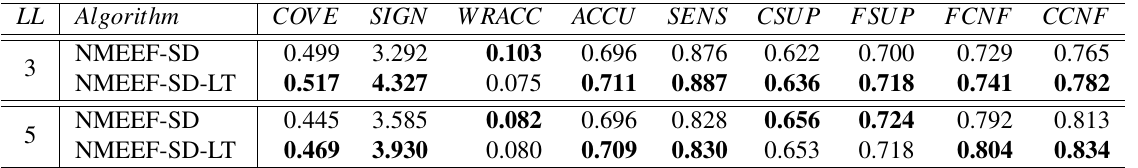
Table 3. Results for the simple NMEEF-SD algorithm and with genetic lateral tuning.